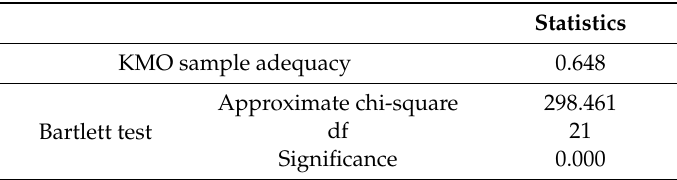
Table 17. KMO sample adequacy and Bartlett test.